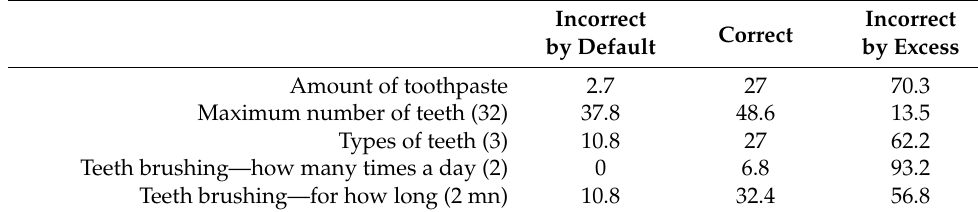
Table 3. Percentage of correct responses by